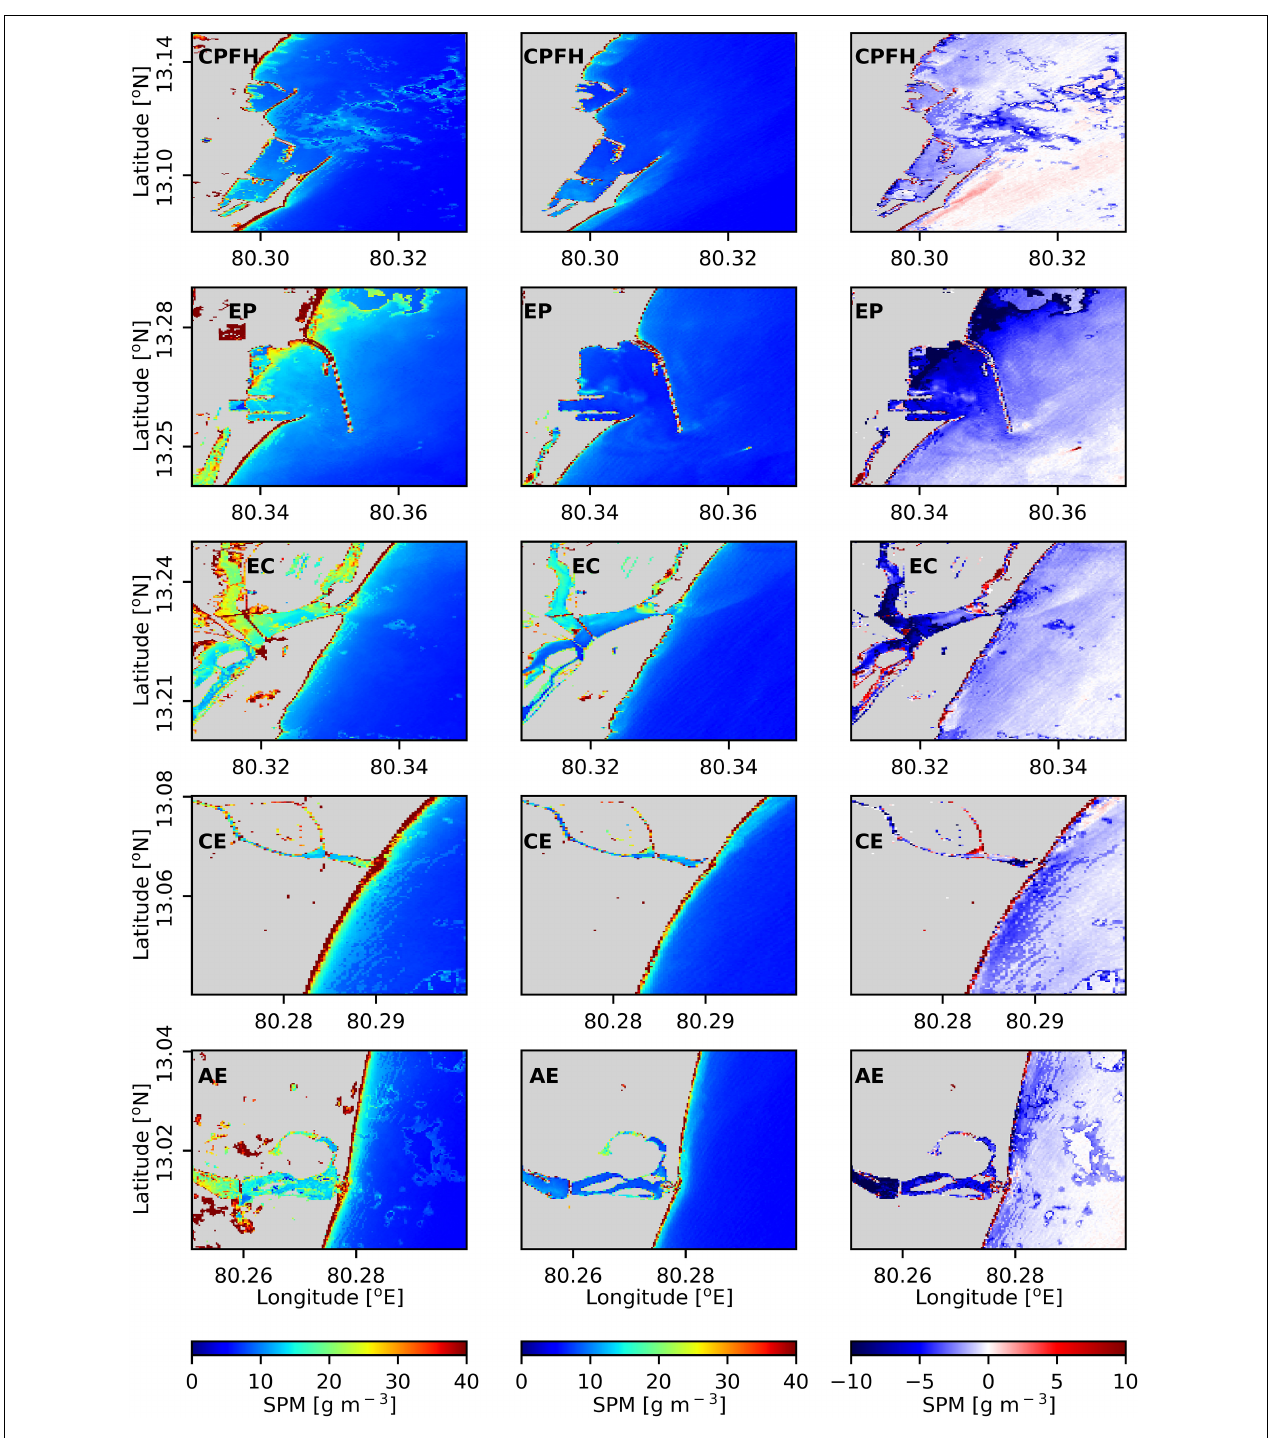
FIGURE 3 | Long-term (left), April 2020 (middle), and April 2020 anomaly (right) mean distributions of SPM over prominent regions in the study area.